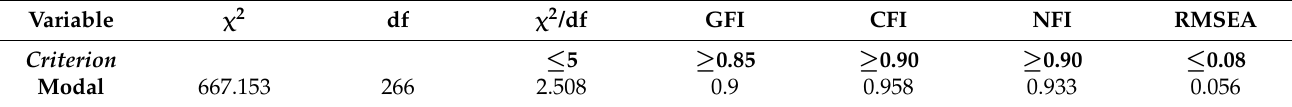
Table 5. The Goodness of Fit Values of the Research Model.